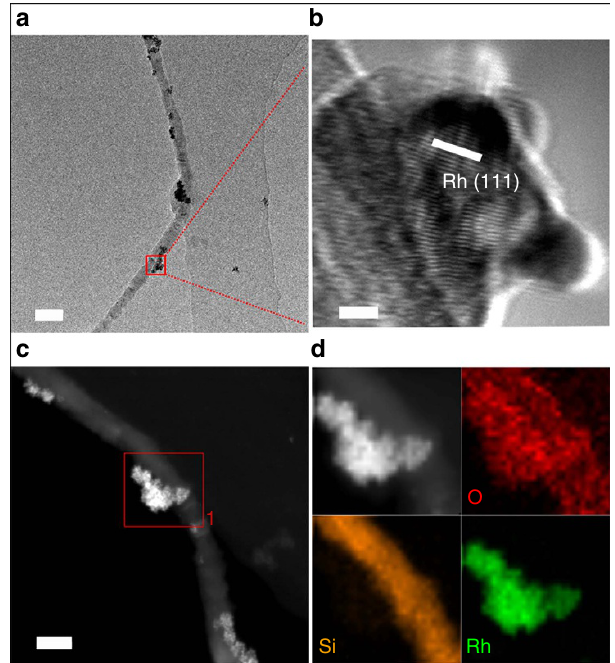
Figure 1 | TEM characterization. ( a ) TEM image of a Rh/SiNW. Scale bar, 100nm. ( b ) Enlarged HRTEM image of the red square in a showing a Rh crystallite. The 0.22nm spacing corresponds to Rh (111). Scale bar, 5nm. ( c ) HAADF-STEM image of a Rh/SiNW. Scale bar, 50nm. ( d ) Its corresponding EDS mapping showing the O, Si and Rh distributions. EDS, energy dispersive spectroscopy; HAADF-STEM, high-angle annular dark field scanning TEM; HRTEM, high-resolution